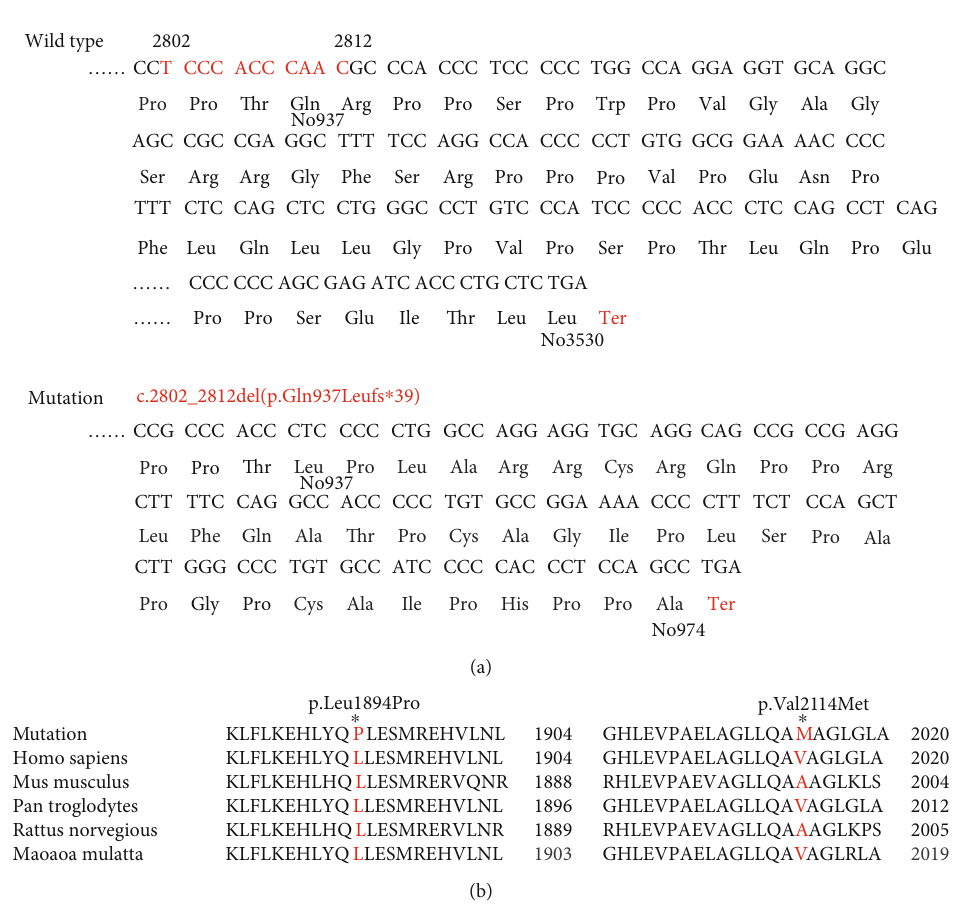
Figure 4: (a) Codon and amino acid coding diagram of the variant c.2802_2812del (p.Gln937Leufs ∗ 39) of the proband II-1 of Family 1. The red letters indicate the changed amino acids and the site of the stop codon. In the mutant, no. 975 amino acid was converted into a termination codon. (b) Evolutionary conservation of no. 1894 and no. 2114 amino acid (red). Mutated site is indicated by an